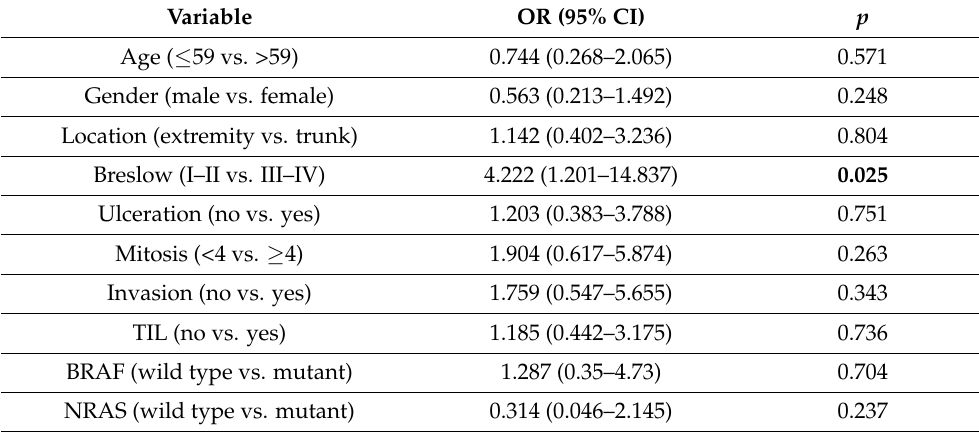
Table 3. Risk factors of sentinel node positivity by the binary logistic regression